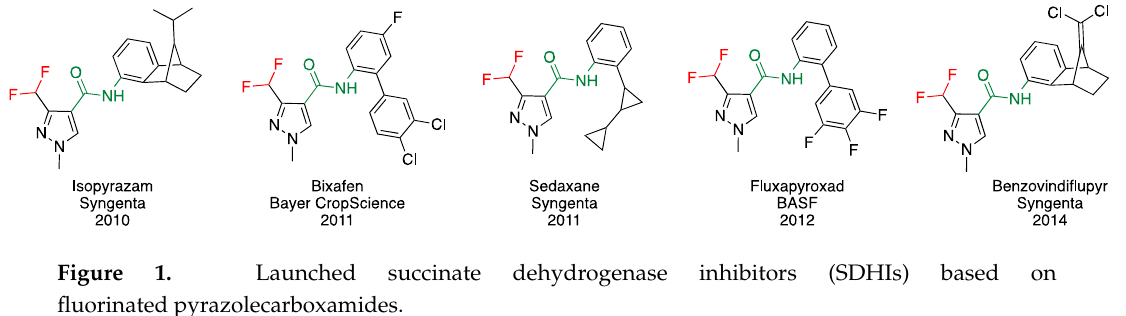
Figure 1. Launched succinate dehydrogenase inhibitors (SDHIs) based on fluorinated pyrazolecarboxamides.